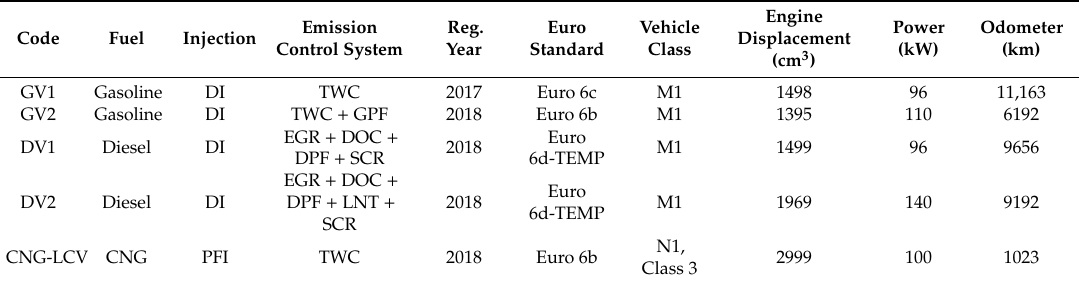
Table 1. Vehicle